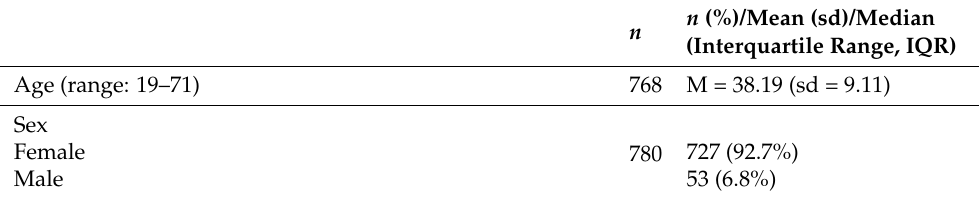
Table 1. Sociodemographic and professional characteristics of the participants ( n =